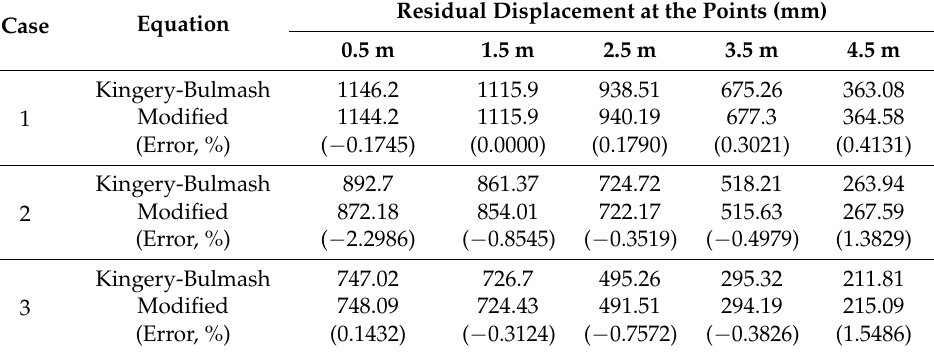
Table 10. Results of Surface Burst